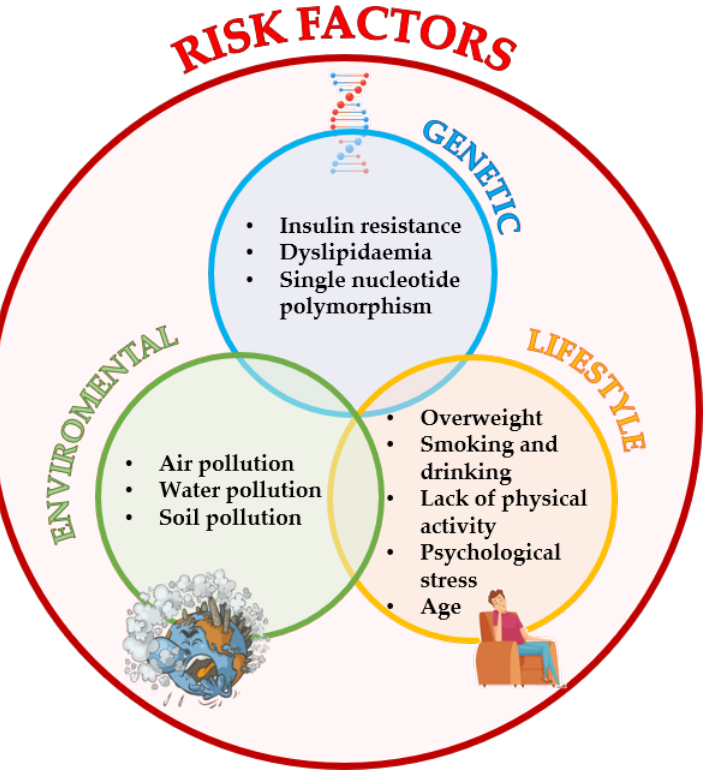
Figure 1. The factors affecting MetS and cancer.